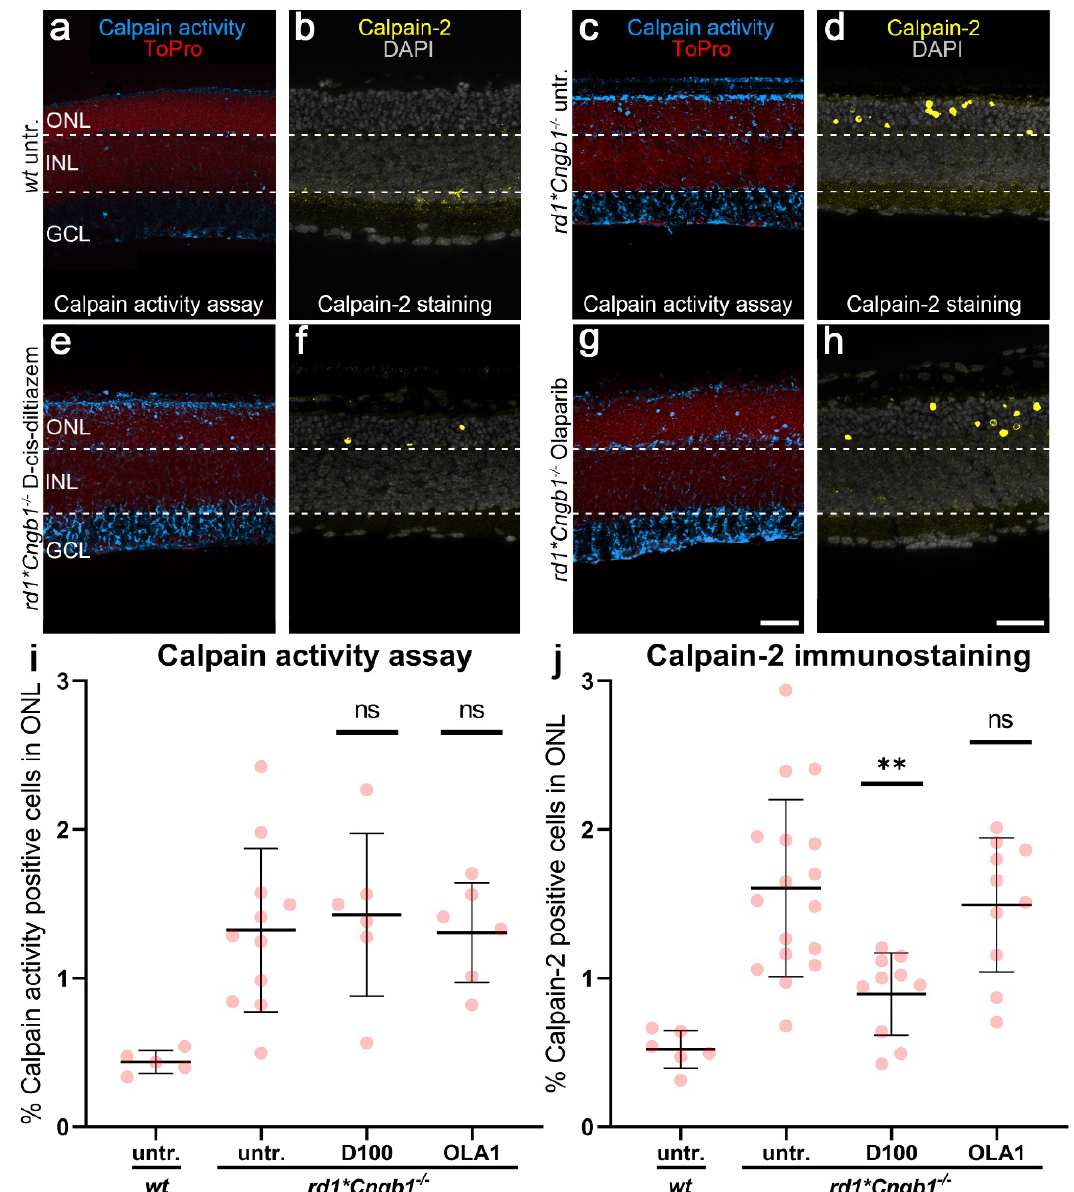
Figure 4. Effects of D-cis-diltiazem and Olaparib on calpain activity in rd1*Cngb1 − / − retina. The calpain activity assay (blue) and an immunostaining for activated calpain-2 (yellow) were performed on wt ( a , b ) and rd1*Cngb1 − / − retina. DAPI (grey) was used as nuclear counterstaining. Untreated rd1*Cngb1 − / − retina (untr.; c , d ) was compared to retina treated with D-cis-diltiazem ( e , f ) or Olaparib ( g , h ). The scatter plots show the percentages of ONL-positive cells for calpain activity ( i ) and activated calpain-2 ( j ) in the wt and treated rd1*Cngb1 − / − retina compared with the rd1*Cngb1 − / − control (untr.). Statistical significance was assessed using one-way ANOVA and Tukey’s multiple comparison post hoc testing performed between the control ( rd1*Cngb1 − / − untreated), 100- µ M D-cis-diltiazem (D100), and 1- µ M Olaparib (OLA1). In rd1*Cngb1 − / − , only D-cis-diltiazem reduced the cells positive for activated calpain-2. In the calpain activity assay, untr. wt : 5 explants from 3 different mice; untr. rd1 * Cngb1 − / − : 11/11; D100 rd1 * Cngb1 − / − : 6/6; OLA1 rd1 * Cngb1 − / − : 6/6; in calpain-2 immunostaining, untr. wt : 6/3; untr. rd1 * Cngb1 − / − : 17/17; D100 rd1 * Cngb1 − / − : 10/10; OLA1 rd1 * Cngb1 − / − : 10/10; error bars represent SD; ns = p > 0.05 and ** = p ≤ 0.01. ToPro (red) and ONL = outer nuclear layer, INL = inner nuclear layer, GCL = ganglion cell layer. Scale bar = 50 µ